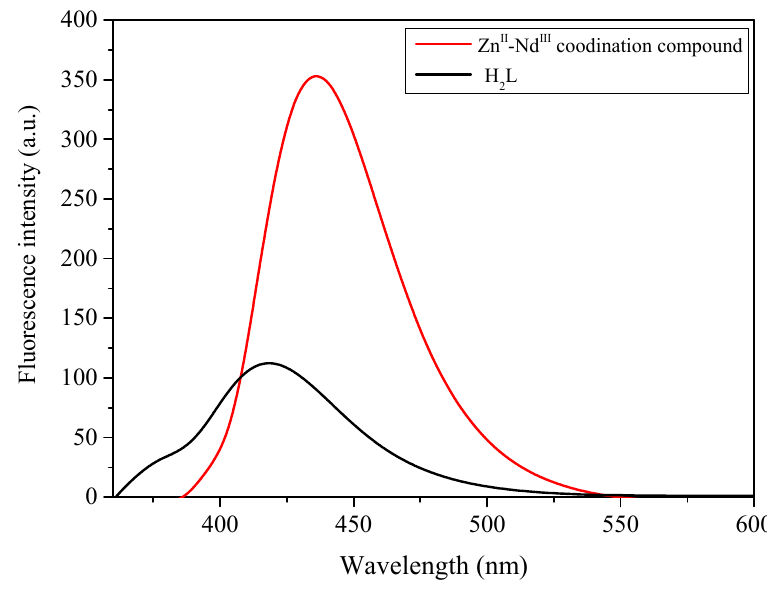
Figure 2. Fluorescence spectra of H 2 L and its corresponding Zn II -Nd III coordination compound.